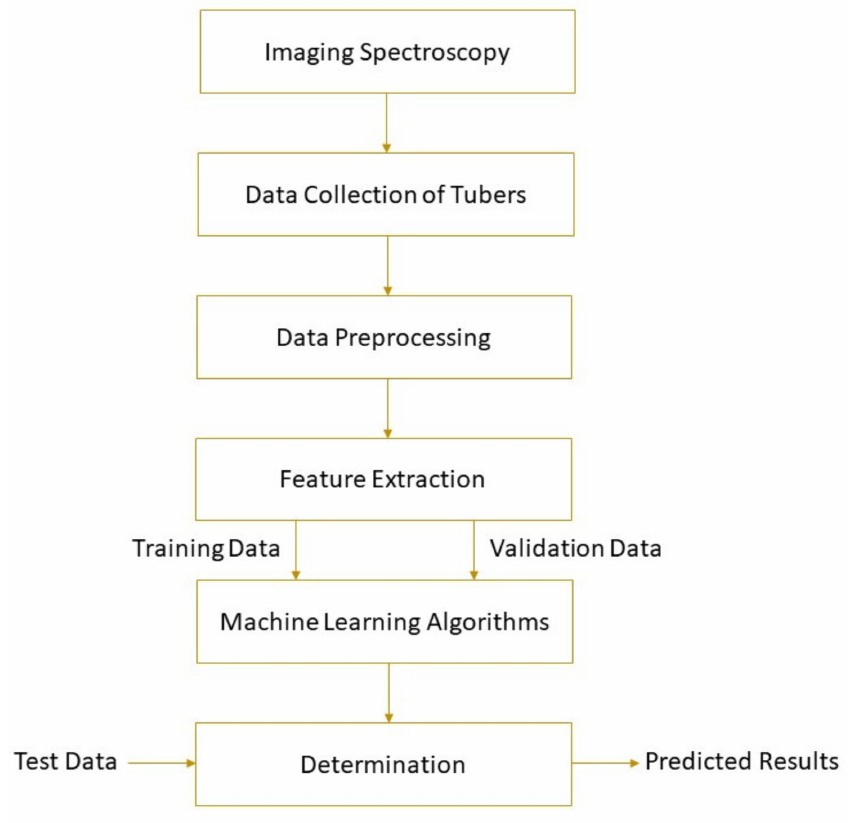
Figure 1. A typical schematic of imaging spectroscopy for tuber quality determinations.